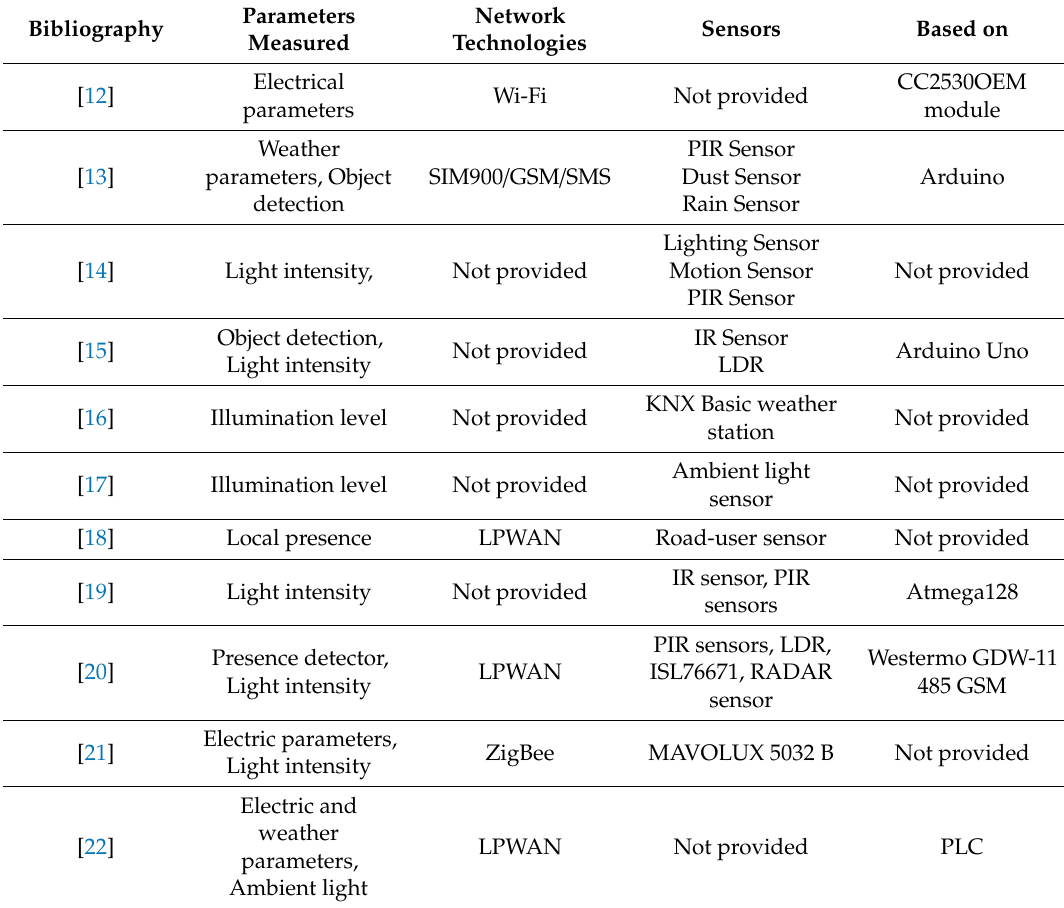
Table 1. Analysis of wireless technologies used in SLs monitoring and